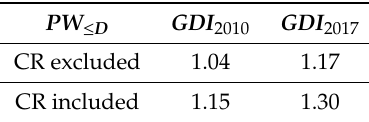
Table 7. GDI variation according to parameters that define the pre-academic role phase (MIUR data 2010, 2017, (Picardi 2019)). PW ≤ D